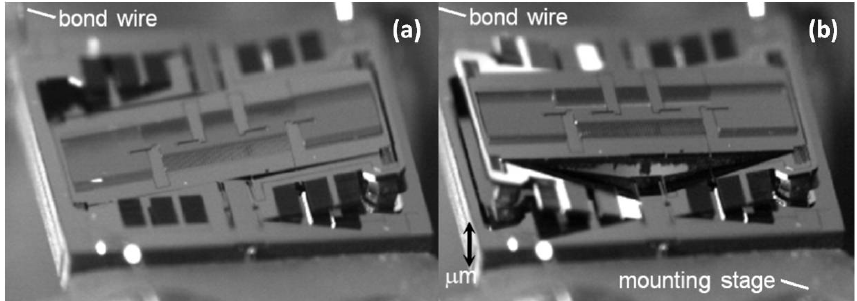
Figure 11. Electrostatic MEMS scanner with switchable lateral and vertical scanning capability. ( a ) Demonstration of the lateral X-axis and Y-axis scanning for horizontal cross-sectional imaging. ( b ) Demonstration of the translational Z-axis scanning for vertical cross-sectional imaging. Reproduced with permission from [48]; published by OSA, 2016.